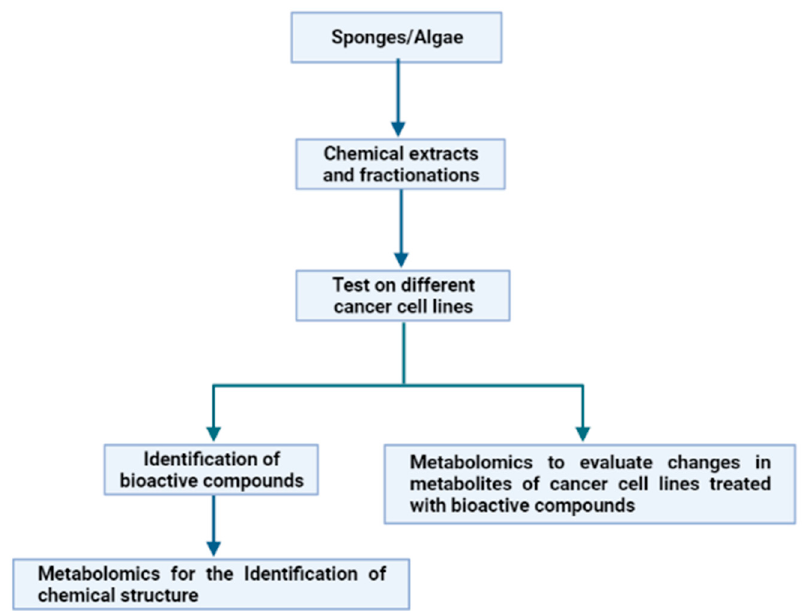
Figure 4. Experimental workflow of the two different applications of metabolomics to the study of marine extracts for anticancer applications.